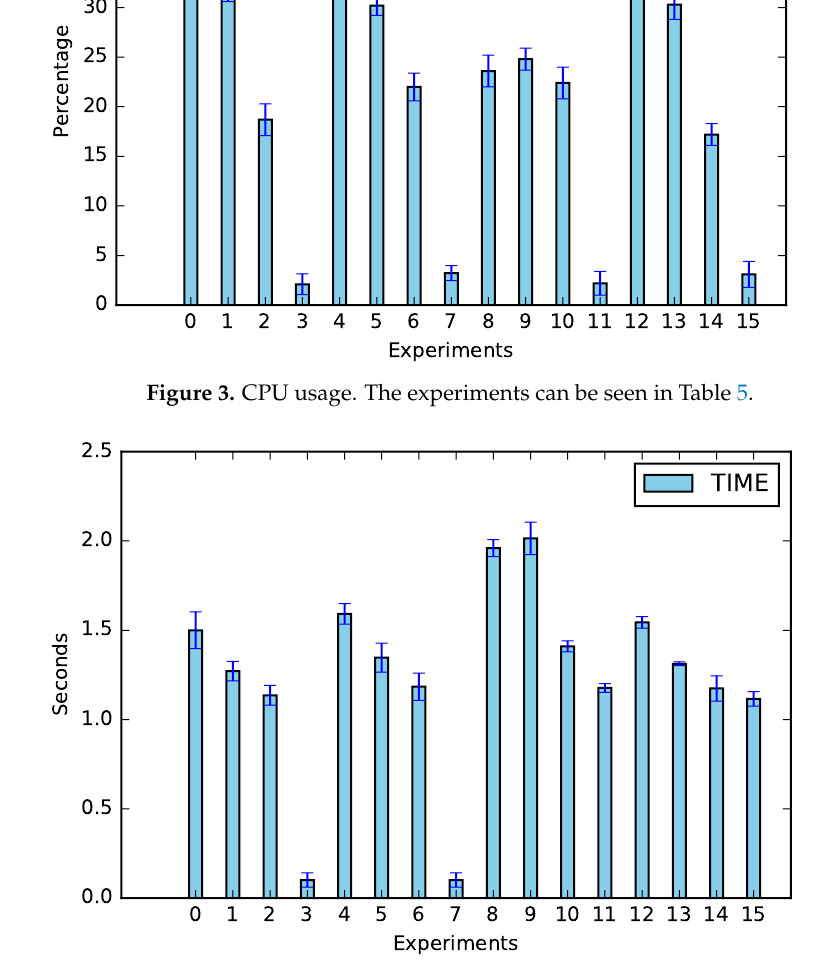
Figure 4. Waiting time for the